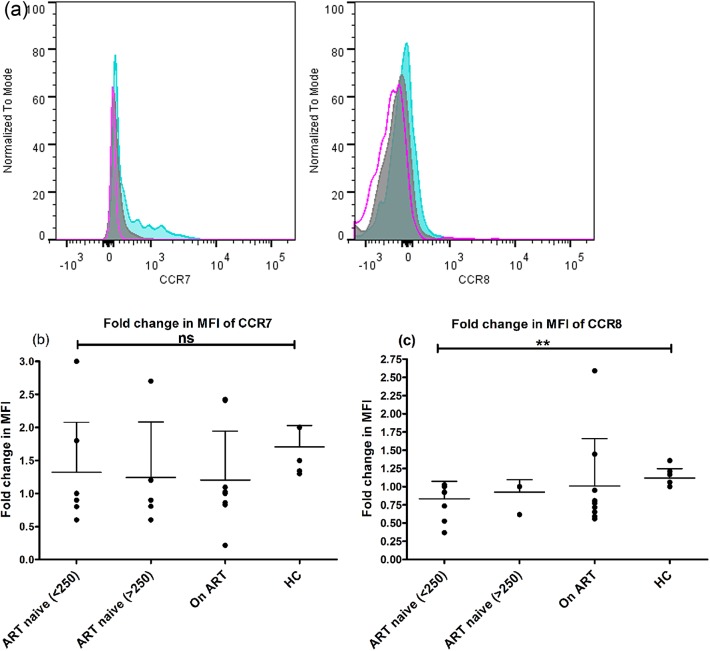
Defective phenotype of mDCs for migration from periphery to lymphoid tissues.(a) A representative flowcytogram of a healthy control subject showing CCR7 and CCR8 expression on mDCs. The open pink histograms shows the isotype control, solid grey histogram shows the unstimulated control and solid blue histogram shows the stimulated control. The ability of mDCs to upregulate chemokine receptors CCR7 (b) and CCR8 (c) in response to a 5-hour stimulation to LPS (500ng/ml) by flowcytometry in ART-naive patients with CD4+ T-cell counts<250 cells/μL (n = 9) and CD4+ T-cell counts>250 cells/μL (n = 5) and compared with patients on ART with CD4+ T-cell counts>350 cells/μL (n = 9). The patients in late stage of HIV had significantly lower ability to up-regulate CCR8 (p<0.05) as compared to HCs. Data are represented as mean±SD. **, P<0.01; ns not significant.